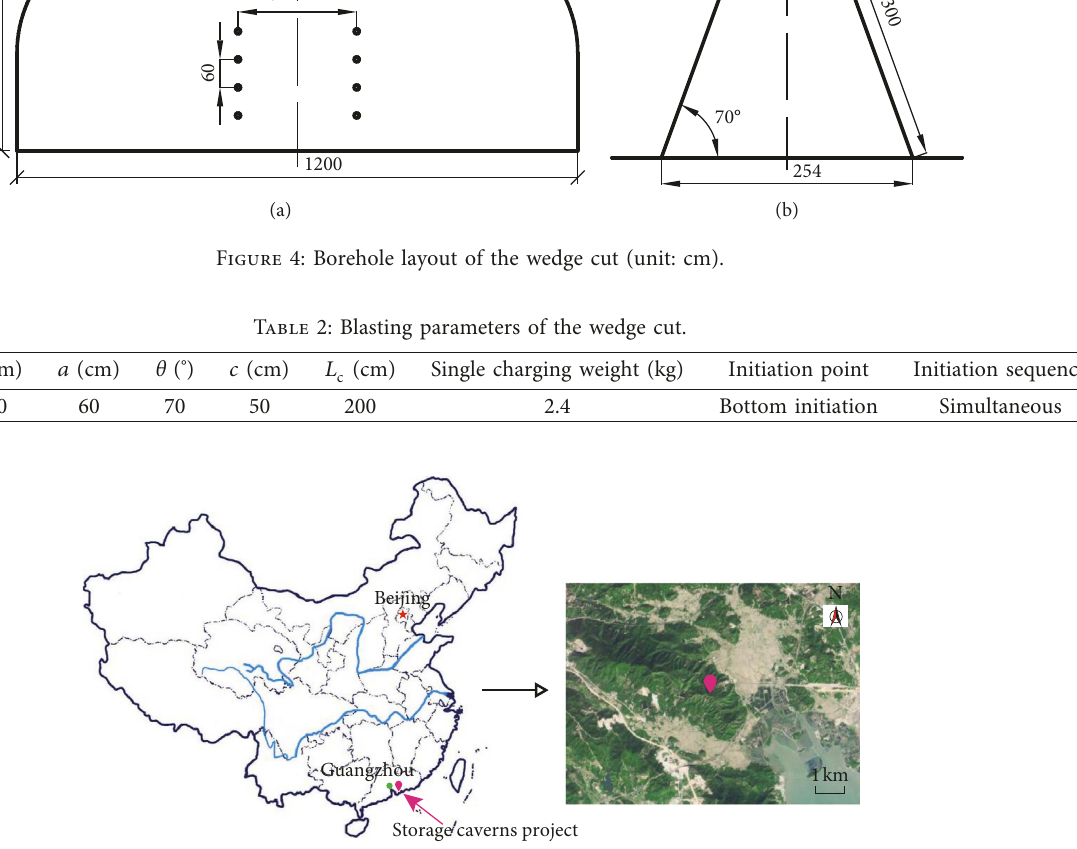
Figure 5: Location of Huizhou underground water-sealed oil storage caverns.